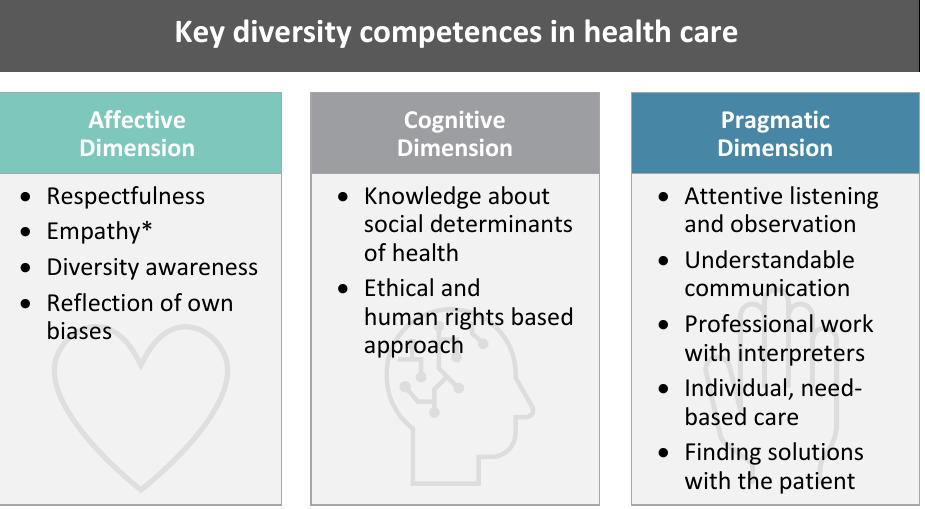
Key diversity competences in health care